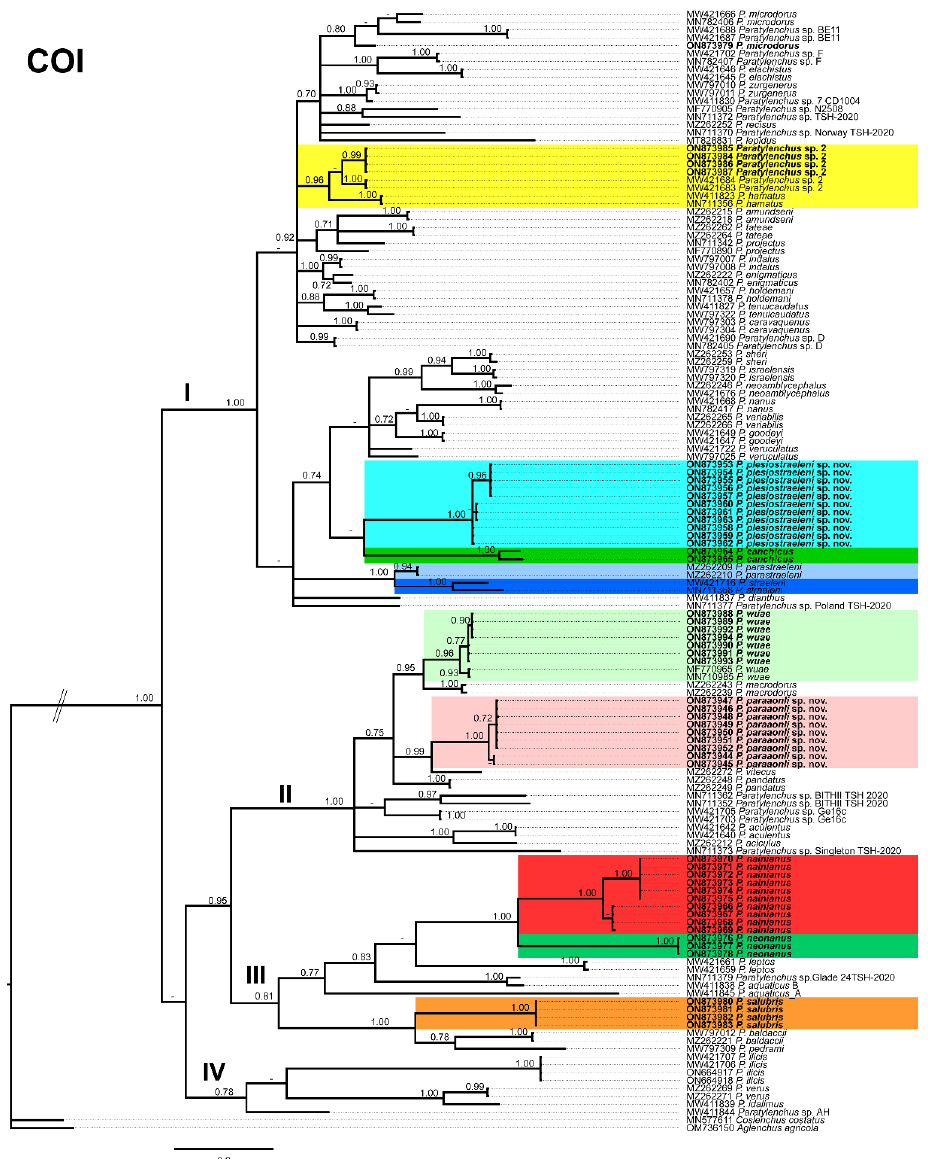
Figure 16. Phylogenetic relationships within the genus Paratylenchus . Bayesian 50% majority rule consensus tree as completed from cytochrome c oxidase subunit 1 (COI) sequence alignment under the general time-reversible model with invariable sites and gamma distribution model (GTR + I + G). Posterior probabilities of more than 0.70 are given for appropriate clades. Newly obtained sequences in this study are shown in bold. The scale bar indicates expected changes per site, and the colored boxes indicate the clade association of new Paratylenchus species sequenced in this